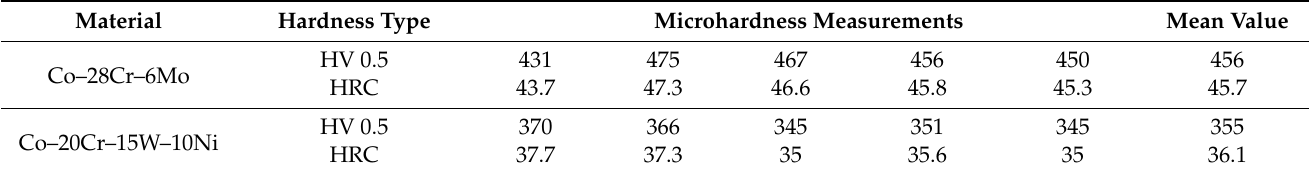
Table 2. CoCrMo alloy and CoCrWNi alloy microhardness effective values.